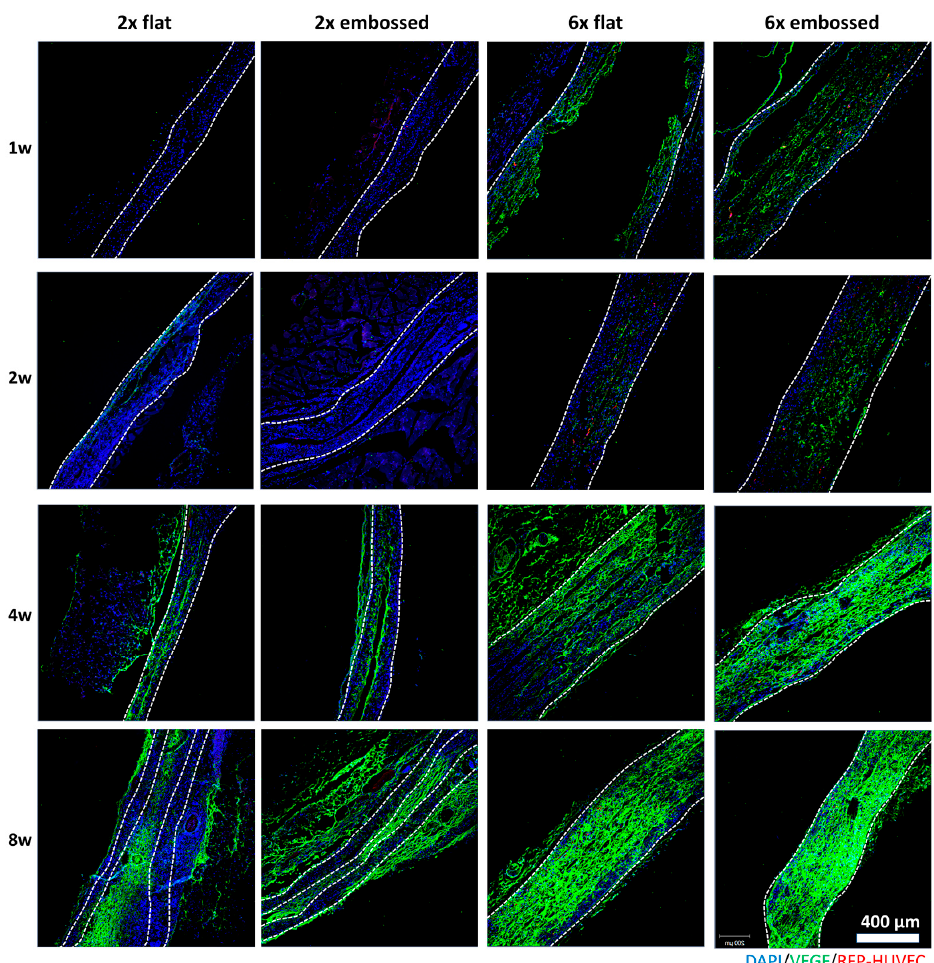
Figure 6. Immunofluorescence images showing differences in VEGF expression in cross-sections of experimental groups at one, two, four, and eight weeks. Dashed lines indicate edge of transplanted embossed sheets. Green: VEGF, red: HUVEC, blue: DAPI. Scale bars are 200 µm.